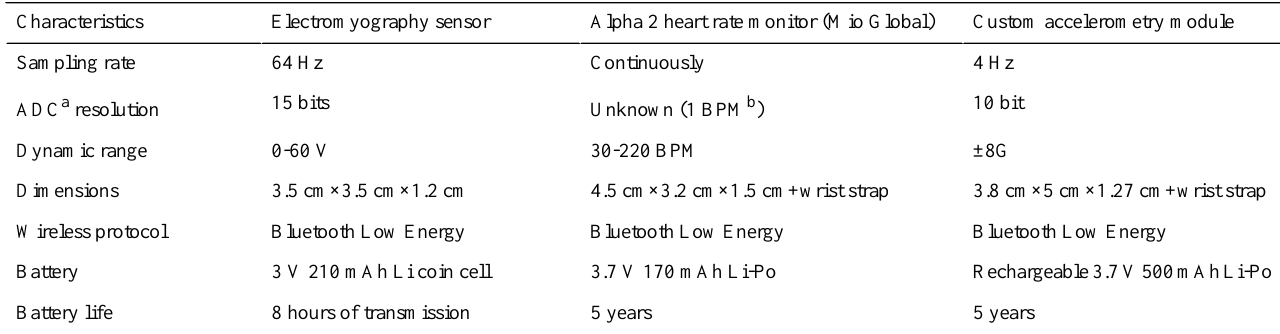
Table 4. Workout on Wheels-Mobile sensor performance specifications.